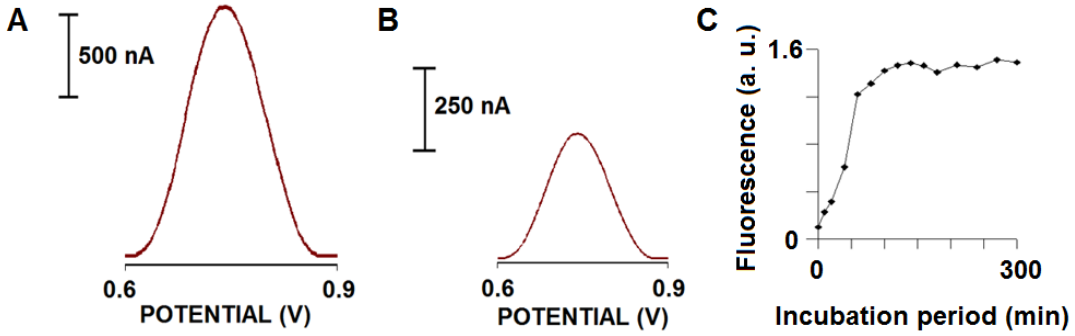
Figure 1. Electrochemical responses of 80 μ M A β -42 before (A) and after (B) aggregation